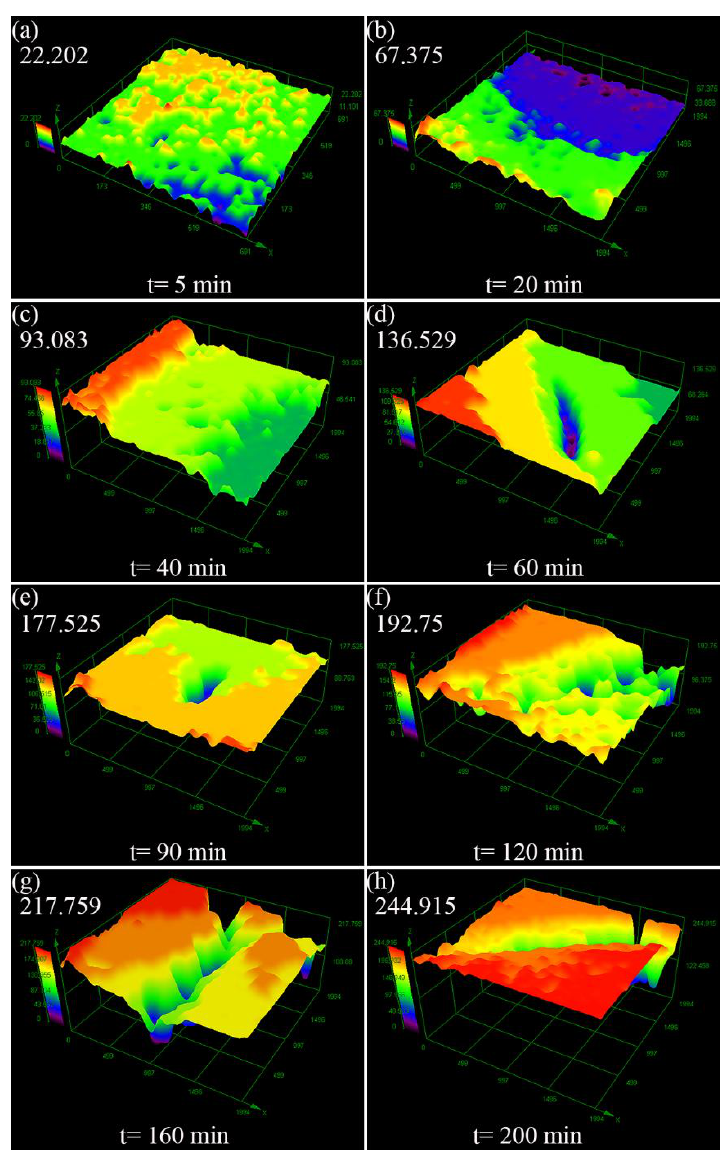
Figure 10. Three-dimensional morphology of Al-5Ti surface after different cavitation erosion time in the distilled water ( a ) 5 min, ( b ) 20 min, ( c ) 40 min, ( d ) 60 min, ( e ) 90 min, ( f ) 120 min, ( g ) 160 min, ( h ) 200 min.